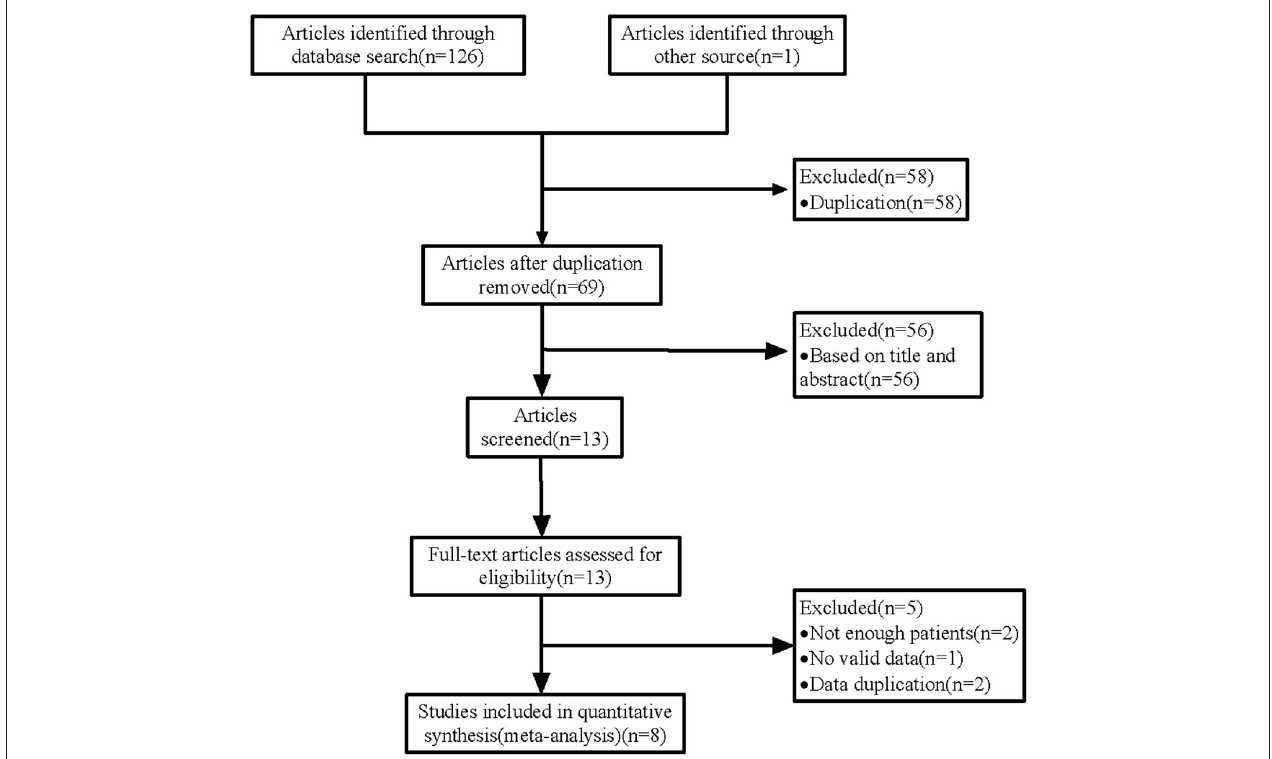
FIGURE 1 | Flow chart of the study